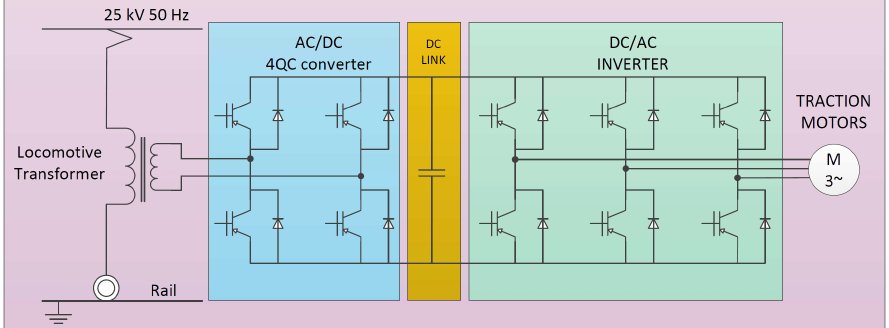
Figure 1. Four-quadrant-converters (4QC) power electronic system used in AC locomotives in 25 kV 50 Hz rail